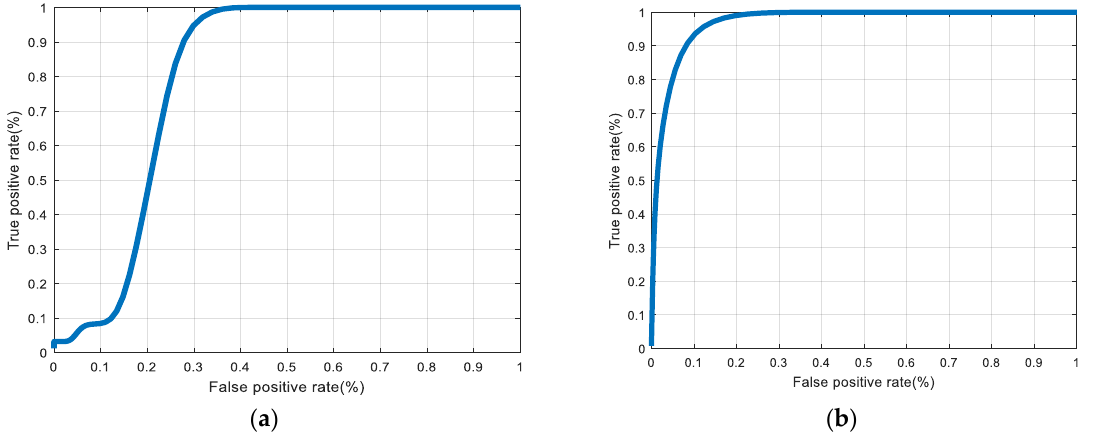
Figure 24. ROC curves for the system using an encrypted kernel in the IWT with different keys of encryption in the presence of noise with a variance of ( a ) = 0.01, and ( b ) = 0.02.